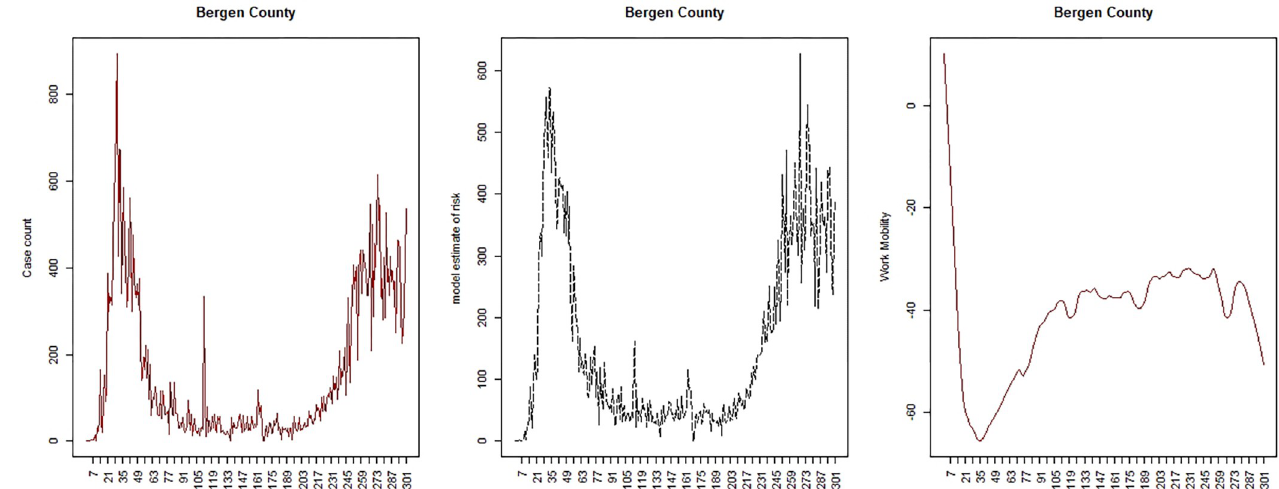
Fig 11. NJ: Bergen county case count, estimated risk and work mobility profile.